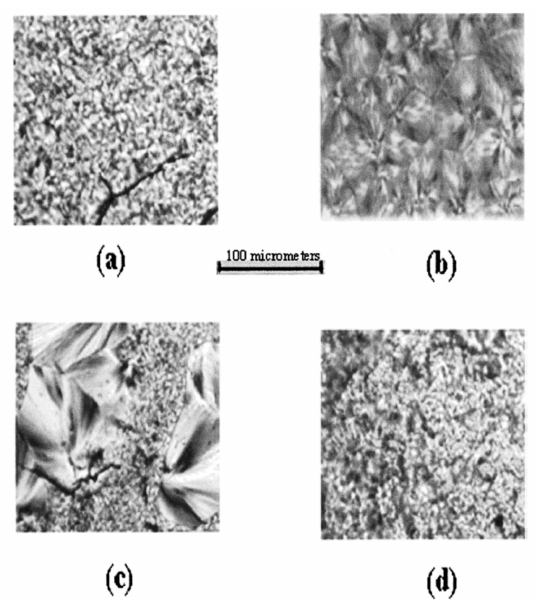
Figure 9. Polarizing photomicrographs of melt pressed ( a ) poly( l -lactic acid) (PLLA), ( b ) PCL, ( c ) solution-cast, and ( d ) melt pressed coalesced PLLA / PCL blends. Reproduced with permission from [29]. Copyright 2012 American Chemical Society.